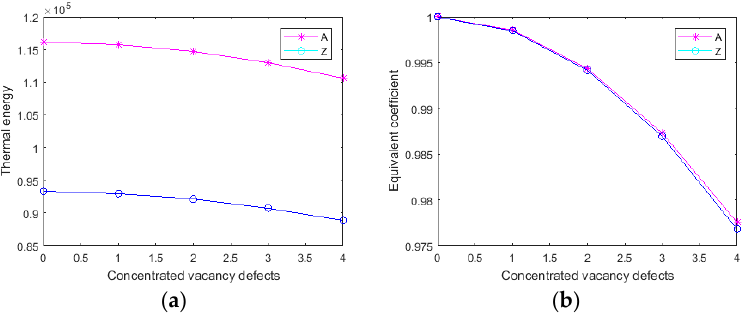
Figure 6. The results of graphene with center concentrated vacancy defects (A—heat source in armchair edges, Z—heat source in zigzag edges, and ( a ) is for the thermal energy, ( b ) is for the equivalent coefficient, unit for thermal energy is J).